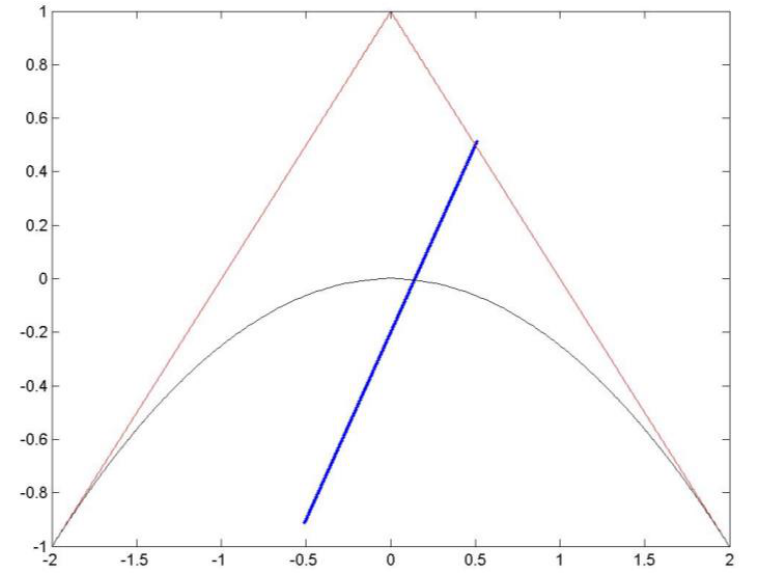
Figure A1. Variations of 𝜙 𝑡1(𝑛) (horizontal) and 𝜙 𝑡2(𝑛) (vertical) with respect to time t for n = 50; inside the triangle corresponds to the causality condition, and the curve separates complex roots (below) from real roots (above).